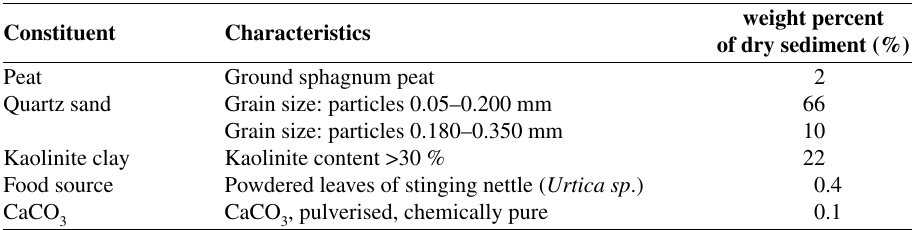
Table 2. Percentage of dry constituents for the artificial sediment 20